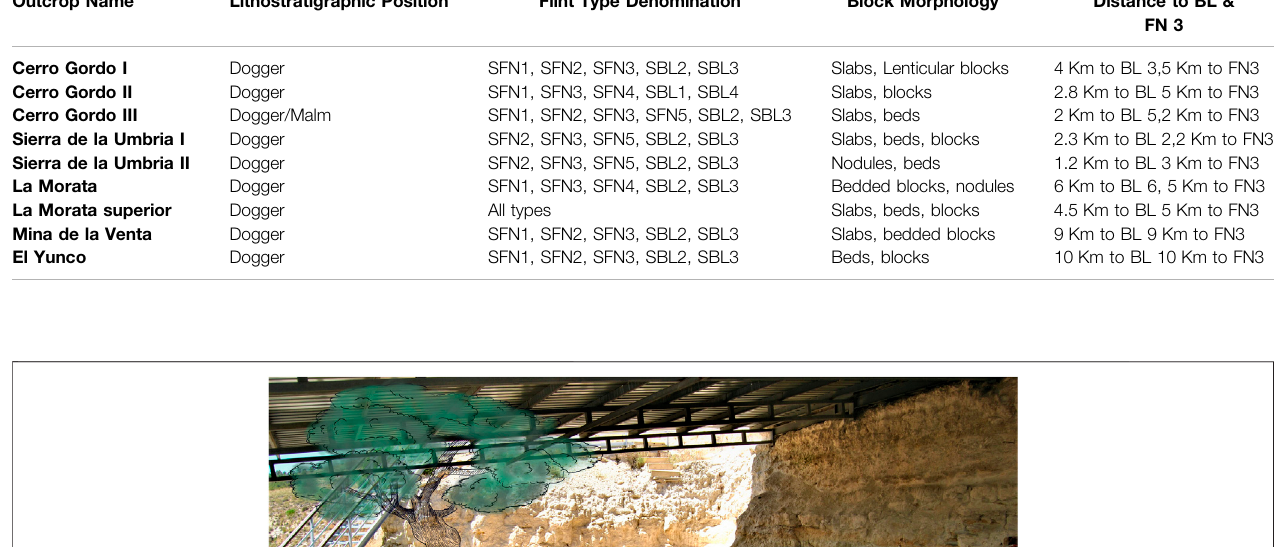
TABLE 3 | Identi fi ed fl int outcrops with their lithostratigraphic position, referential fl int type denomination, block morphology and distance to the Barranco León and Fuente Nueva 3 Oldowan sites. Outcrop Name